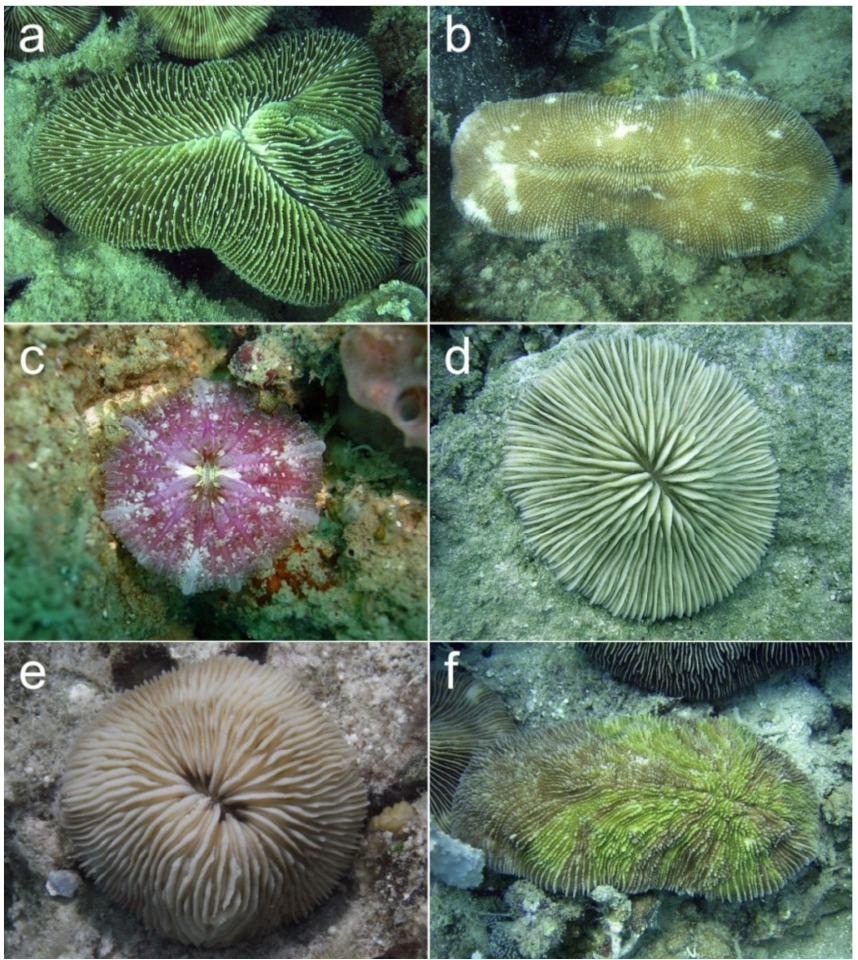
Figure 5. Free-living mid-slope mushroom corals at zones 2–3: ( a ) Ctenactis albitentaculata at NW Pulau Belanda; ( b ) Ctenactis crassa at S Pulau Tikus; ( c ) Cycloseris boschmai at E Karang Jong; ( d ) C. cyclolites at S Pulau Pari; ( e ) C. tenuis at E Pulau Peniki; ( f ) Sandalolitha dentata at S Pulau Kotok